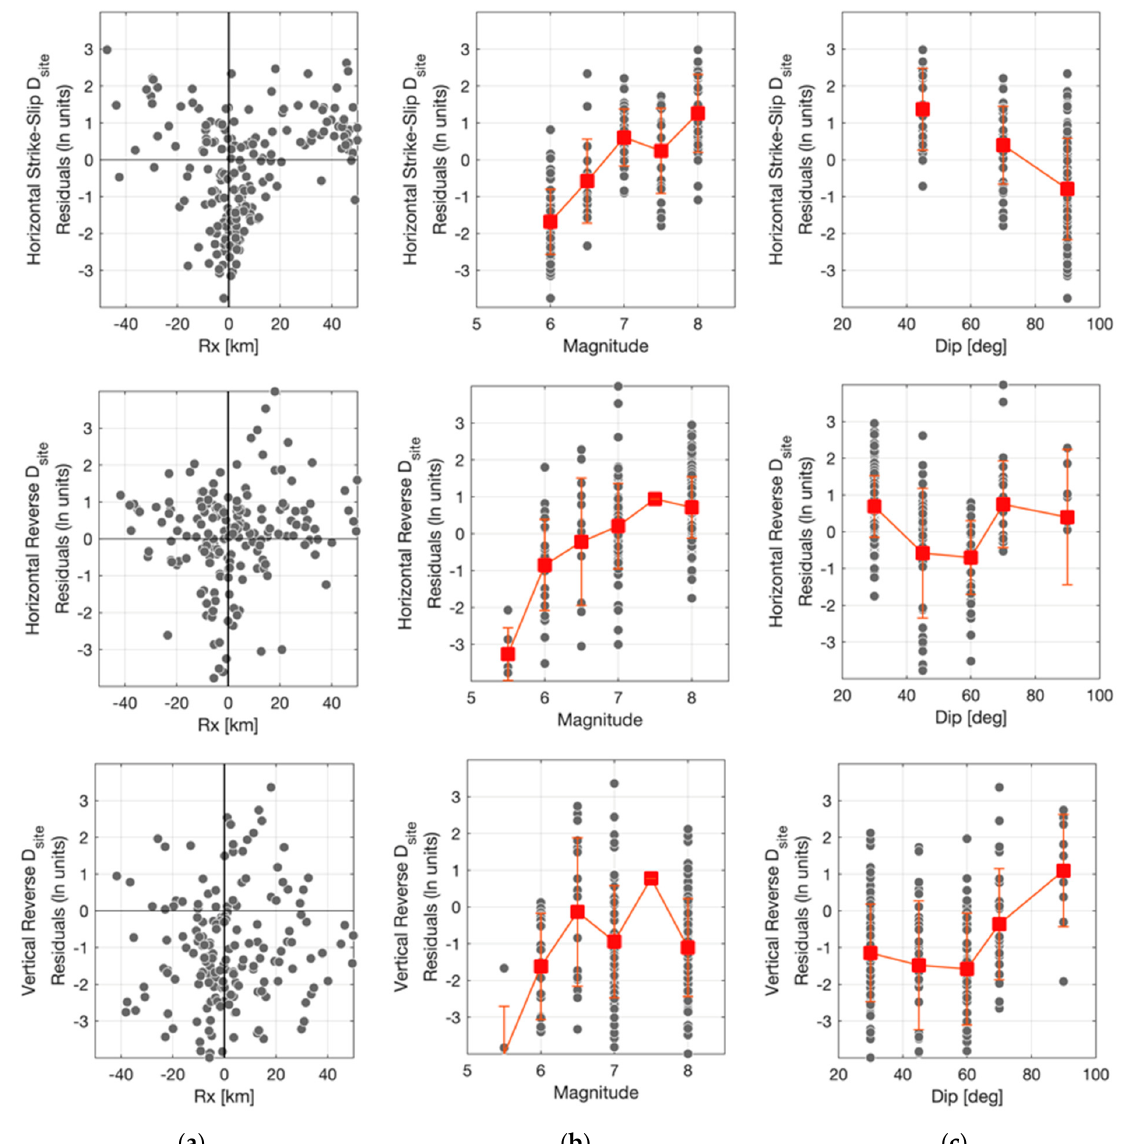
Figure 10. D site model residuals versus R x ( a ), magnitude ( b ), and dip ( c ), showing the (top) horizontal strike-slip, (middle) horizontal reverse, and (bottom) vertical reverse. The grey circles represent individual residuals, whereas the red error bars show the mean and standard deviation for each magnitude or dip bin.